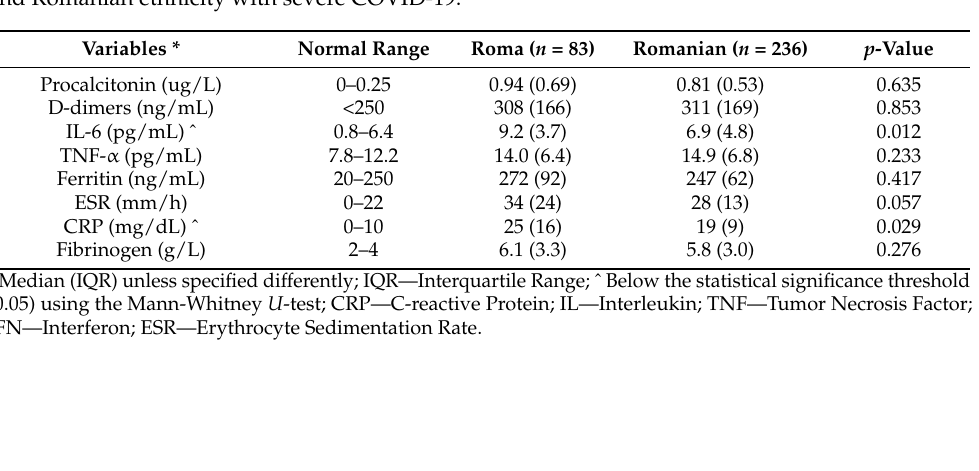
Table 4. Comparison of cytokines and inflammatory markers at admission between patients of Roma and Romanian ethnicity with severe